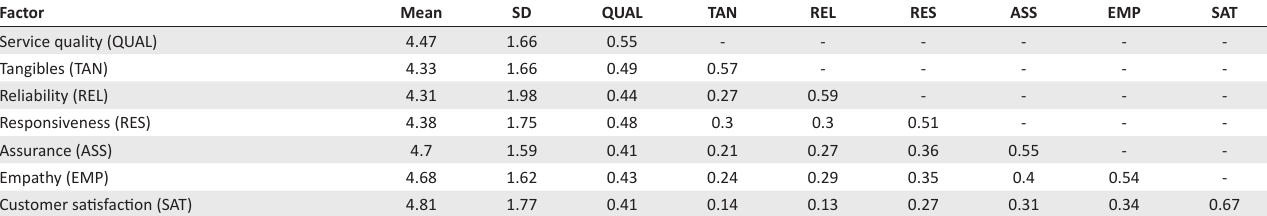
TABLE 4: Mean, standard deviation, SICs and AVE. Factor